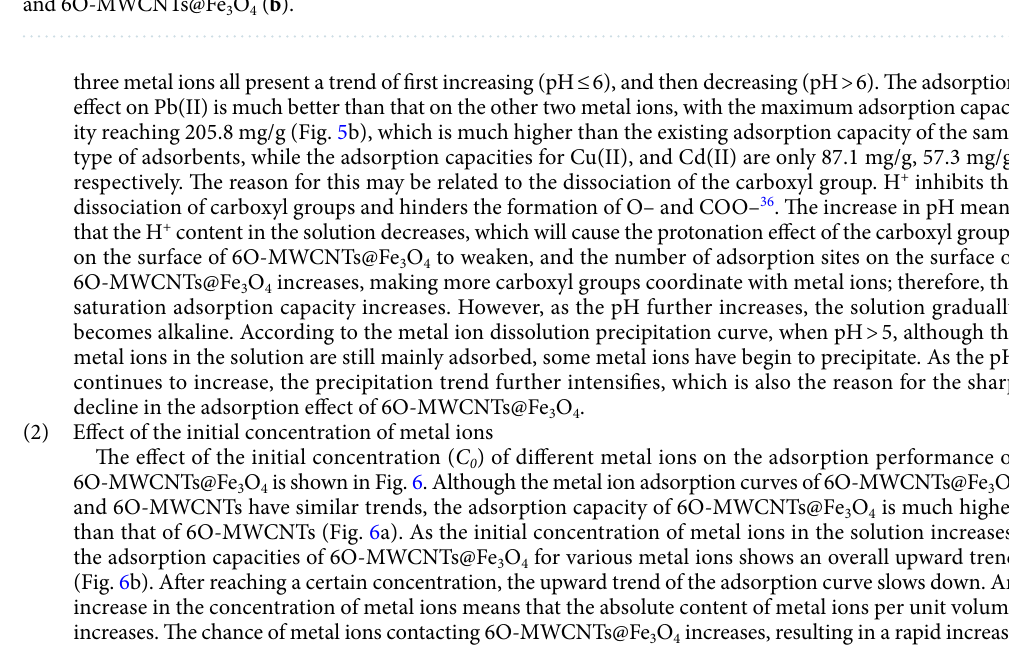
Figure 6. Effect of the initial concentration of metal ions on the adsorption performance of 6O-MWCNTs ( a ) and